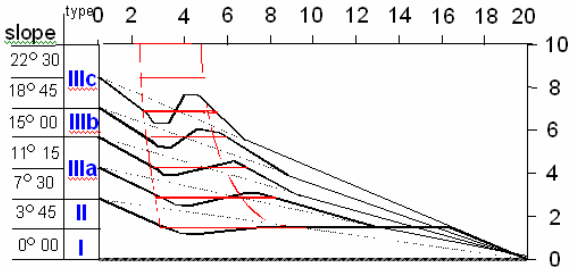
Fig. 1. Classifications of terracing by Czerkasov